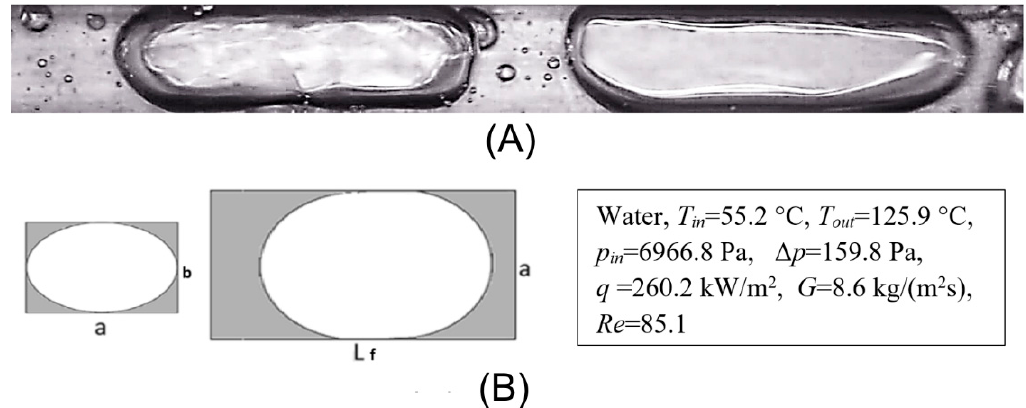
Figure 7. ( A ) Case I—top view video frame; ( B ) predicted, approximate shape of small vapor bubbles in cross section (left) and top view (right) of the mini-channel.